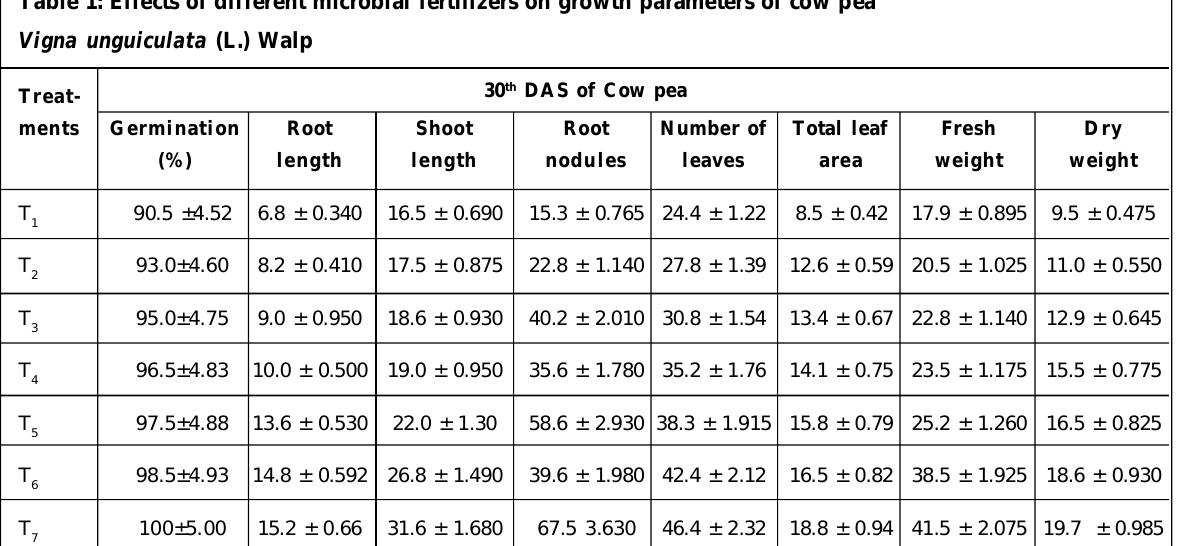
Rhizobium + and T 7-